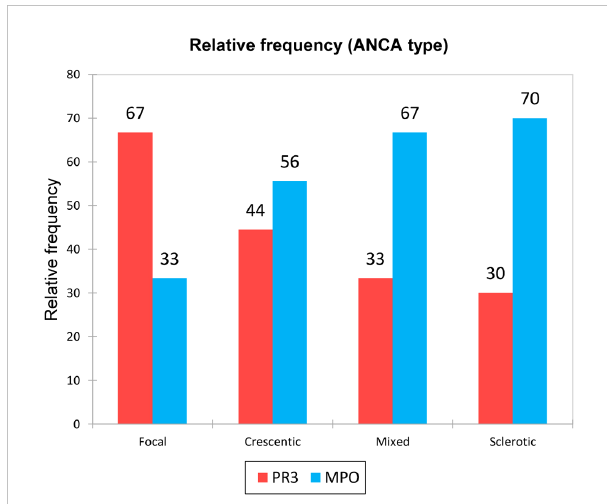
FIGURE 3 Relative frequency of ANCA type for the different biopsy classes.